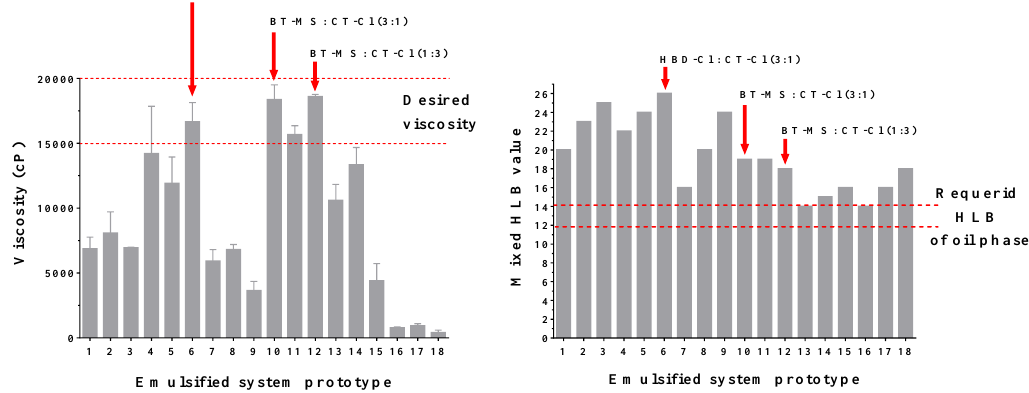
Figure 4. Results of viscosity and mixed HLB values for the emulsified prototypes.